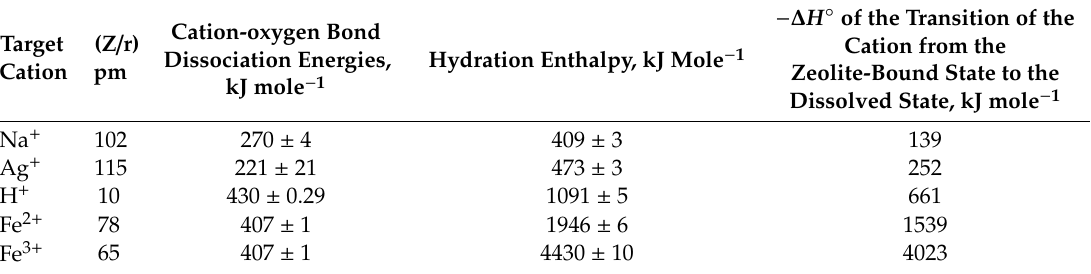
Table 2. Parameters of the target